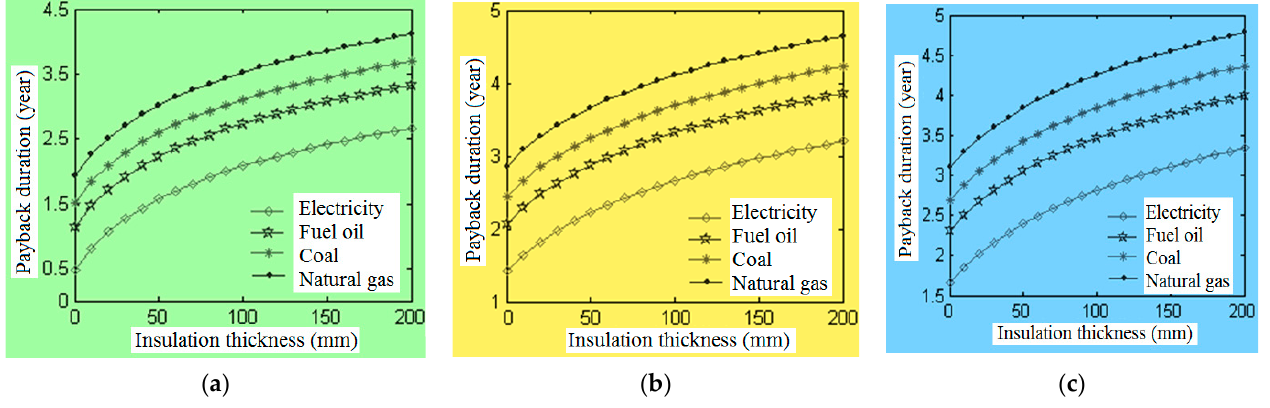
Figure 6. Impact of insulating thickness on payback duration for energy source types (extruded polystyrene insulating material): ( a ) Porous light brick wall; ( b ) Gas concrete wall; ( c ) Bims wall.